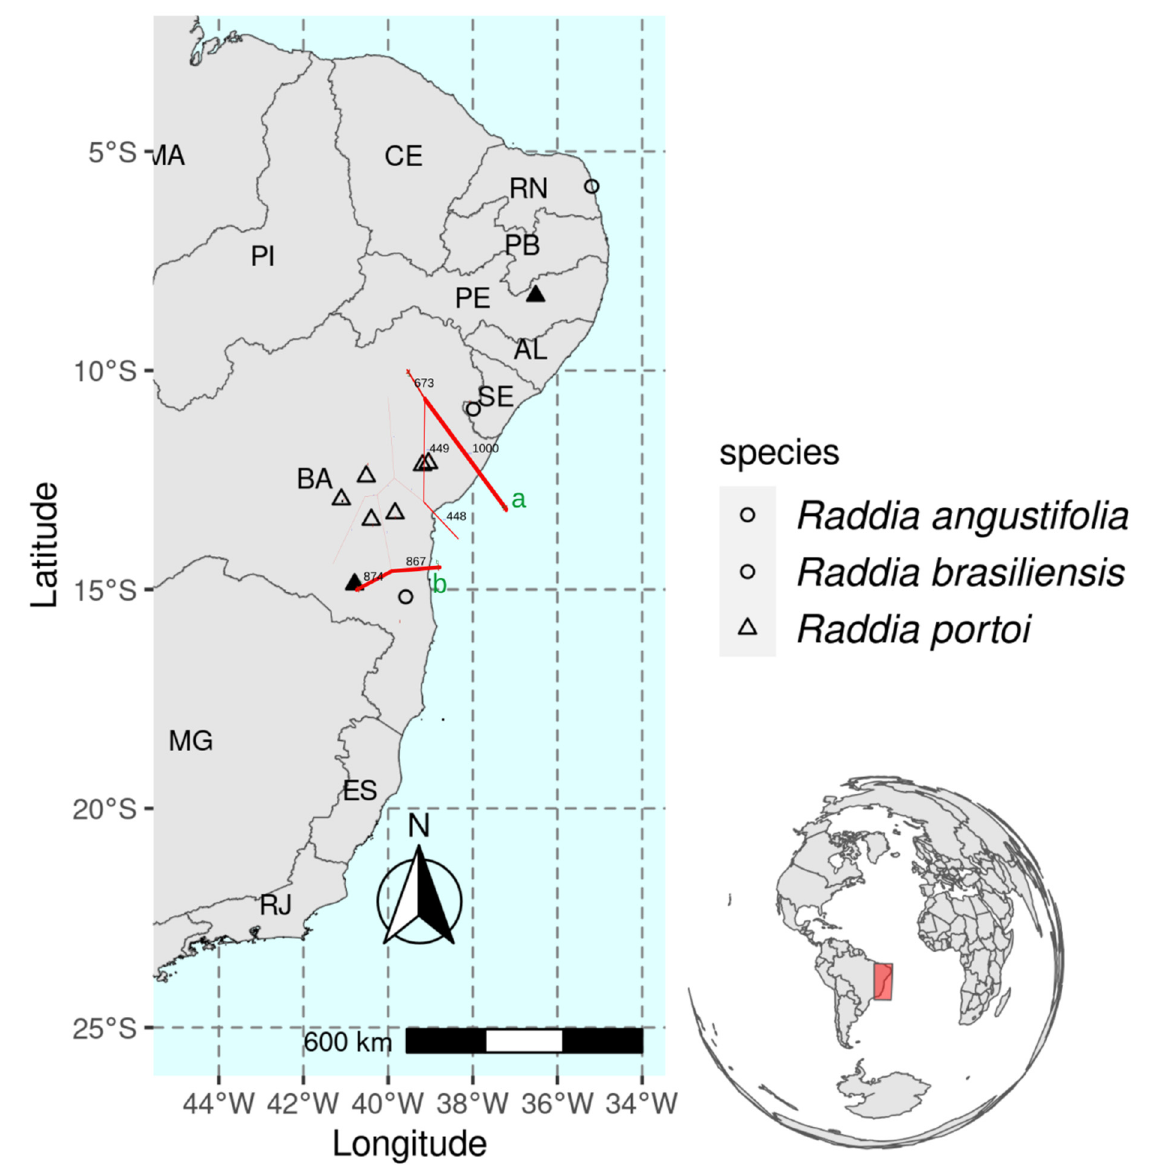
Figure 5. Population locations and inferred genetic barriers to gene flow. The barriers a and b were inferred from the real data (90 polymorphic ISSR loci). Values above barriers represent the number of inferred barriers and the thickness of the barriers is proportional to their support, generated via 1000 bootstrap replications of the empirical data. Full triangles are Raddia portoi populations sampled only for sequence data.